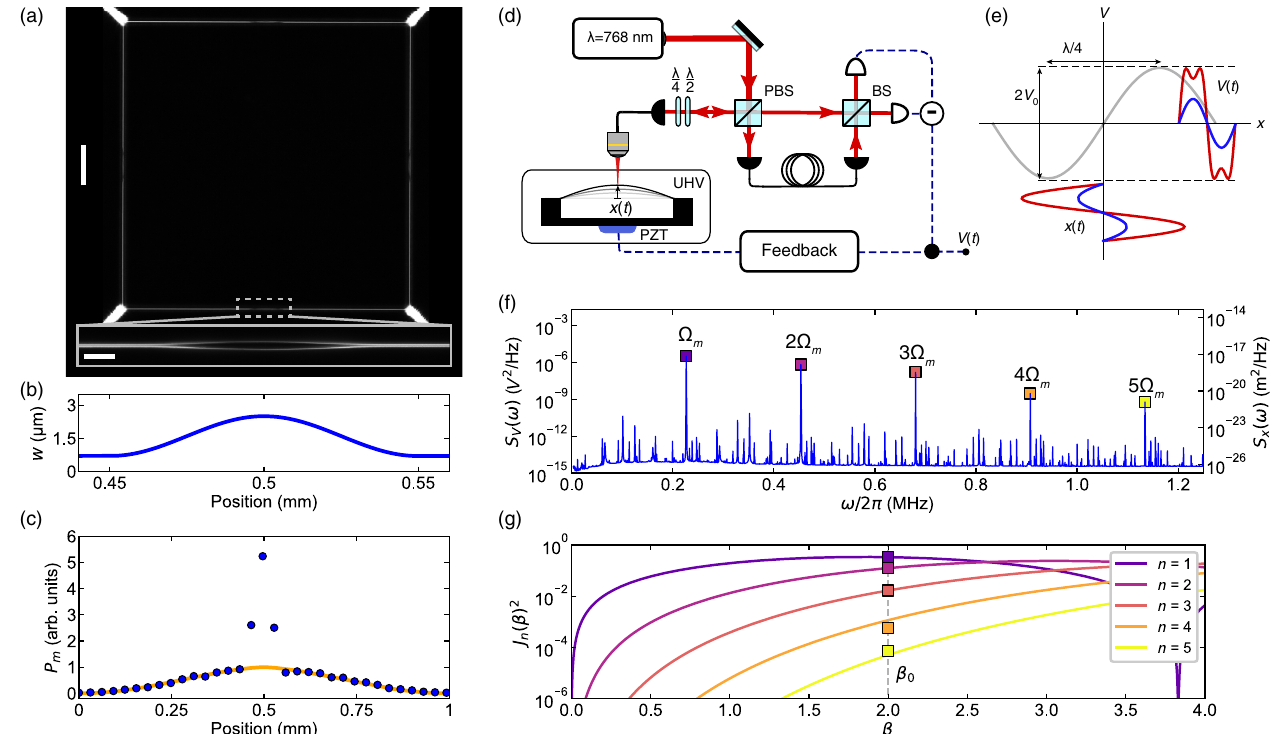
FIG. 4. Polygon resonators with width corrugations and interferometric readout. (a) Dark-field microscope image of a square-shaped polygon resonator with width corrugations (inset). White scale bars: main image, 100 μ m; inset, 10 μ m. Device parameters: 0 . 35 , and w 2 . 5 μ m in the width corrugation. (b) The width profile of the pad shown in the l 0 ¼ 700 μ m, r 0 increased from 700 nm to l ¼ inset of (a). (c) Perimeter mode thermomechanical sideband power at different positions on the side segment of a 1 mm square-shaped polygon resonator with width corrugations similar to the ones shown in (a) and (b). Blue circles: measured sideband power. Orange curve: expectation from the mode shape of the perimeter mode along a side segment (obtained from a FEM simulation). (d) Experimental setup used for interferometric position measurement and feedback control of the resonators. UHV: ultrahigh vacuum chamber with pressure below 10 − 8 mbar. PZT: piezoelectric actuator. Feedback: lock-in amplifier and digital phase-locked loop (PLL) employed to synthesize a feedback signal for the piezoelectric actuator. (e) Working principle of displacement calibration using nonlinear transduction in an interferometer. The gray line shows the transduction curve of the interferometer. The blue and red lines correspond to ω Þ (left) and corresponding calibrated linear and nonlinear transduction regimes, respectively. (f) PSD of the homodyne signal S V ð ω Þ (right) for the driven motion of the perimeter mode. Boxes mark sidebands at the higher-order harmonics of the displacement PSD S x ð perimeter mode that are created due to the interferometer nonlinearity. (g) Fit of the first five Bessel functions to the five sidebands shown in (f). Gray dashed line corresponds to the fit value for β 0 and boxes correspond to the normalized sideband amplitude ϕ A =V 0 q 0 Þ n n ð